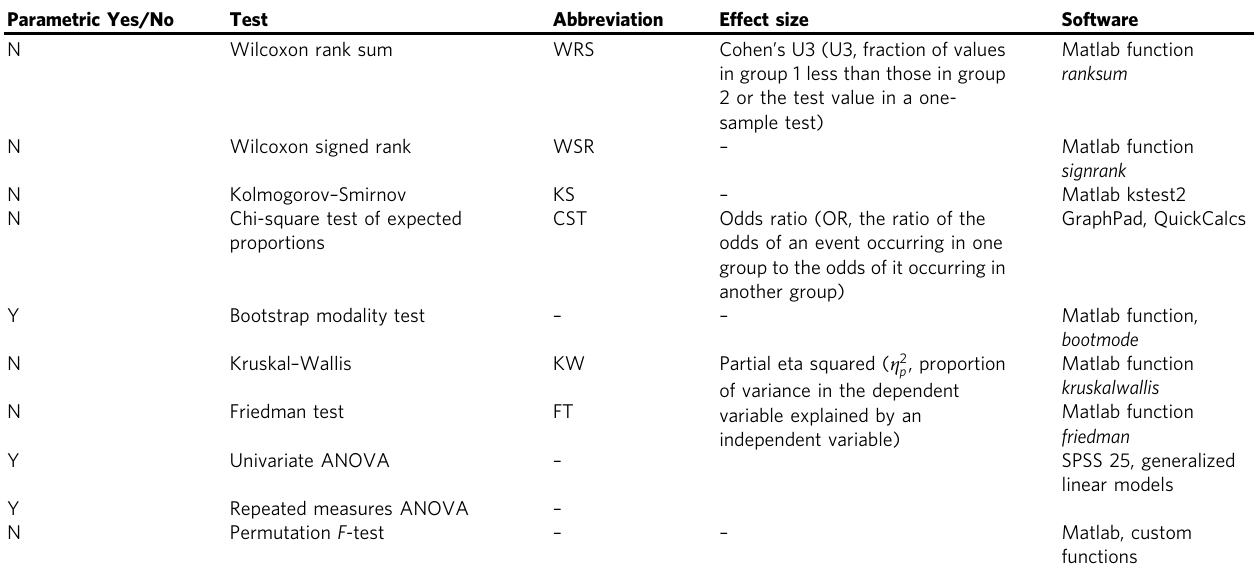
Table 2 Summary of statistical tests, their abbreviations and software